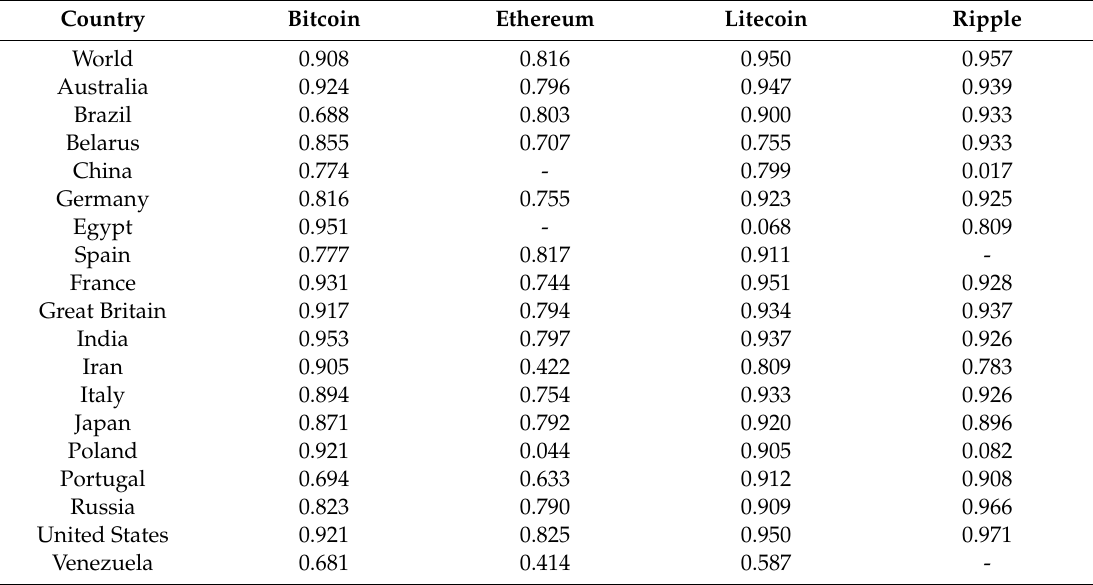
Table 7. Correlations between Wikipedia all agents visits and Google Trends weekly data.